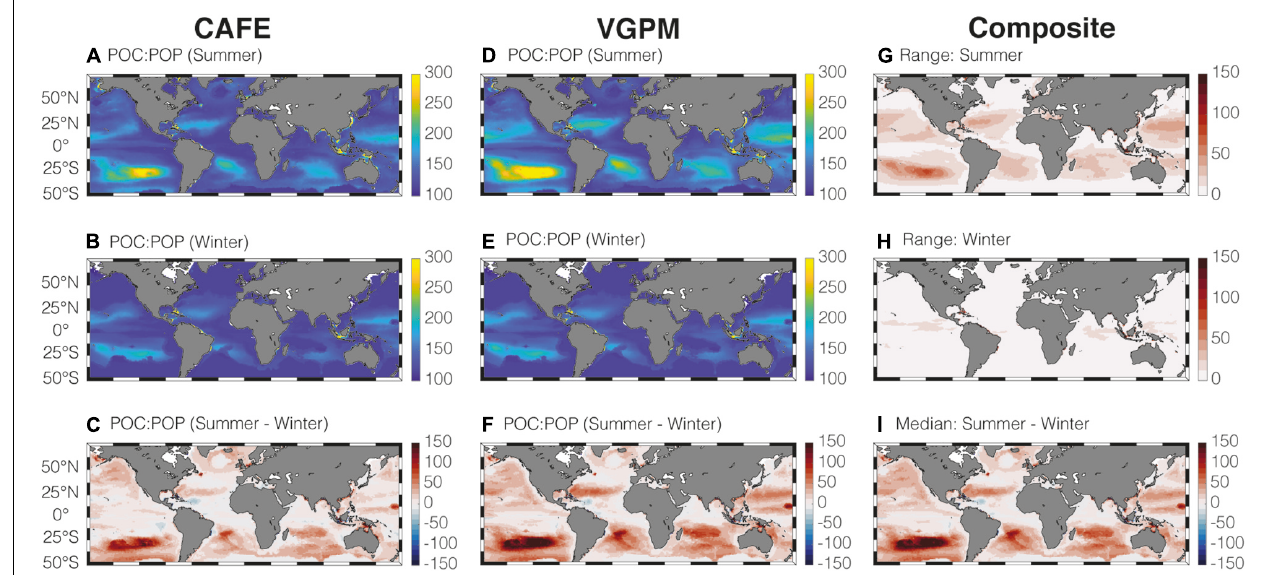
FIGURE 5 | Global climatology of average summer and winter CAFE-informed POC:POP (A–C) and VGPM-informed POC:POP (D–F) in the surface mixed layer. Panels (G,H) show the range in satellite-informed POC:POP, for summer and winter, respectively. Panel (I) shows the seasonal change in median POC:POP.